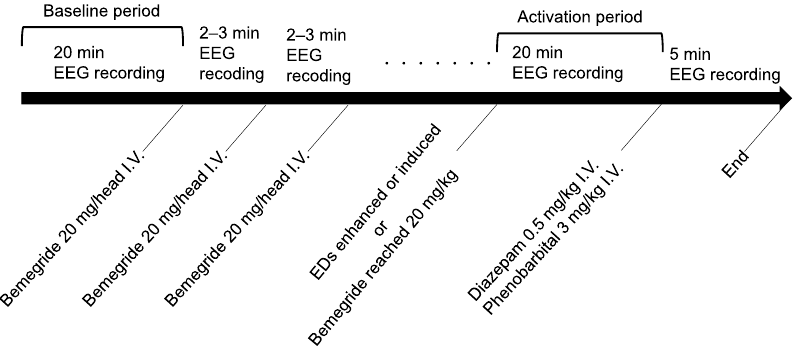
Figure 2. Timetable of bemegride administration and EEG recordings during the experiment. I. V.: intravenous injection.